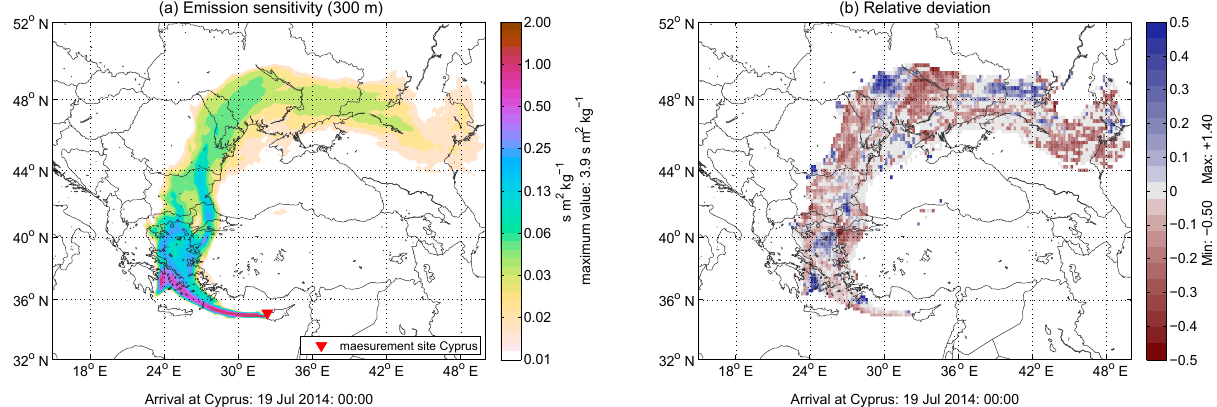
Figure 2. (a) Time integrated emission sensitivity referring to the constant 300m footprint layer height assumption for a 5-day backward simulation started on 19 July 2014, 00:00UTC (03:00LT), at Cyprus. Sensitivities below 0 . 01sm − 2 kg − 1 are not considered. (b) Relative difference in emission sensitivity introduced by differences between local boundary layer heights and the constant 300m footprint layer height. Only absolute sensitivity differences above 0 . 0025sm − 2 kg − 1 are used to calculate relative differences.